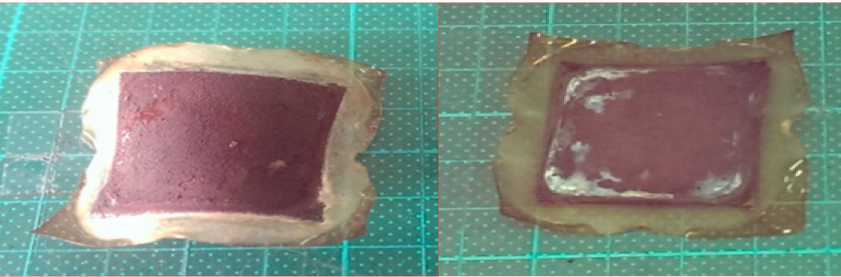
Figure 6. Accelerating electrolysis test—high voltage (4.5 V) and high-temperature drying (160 ◦ C).